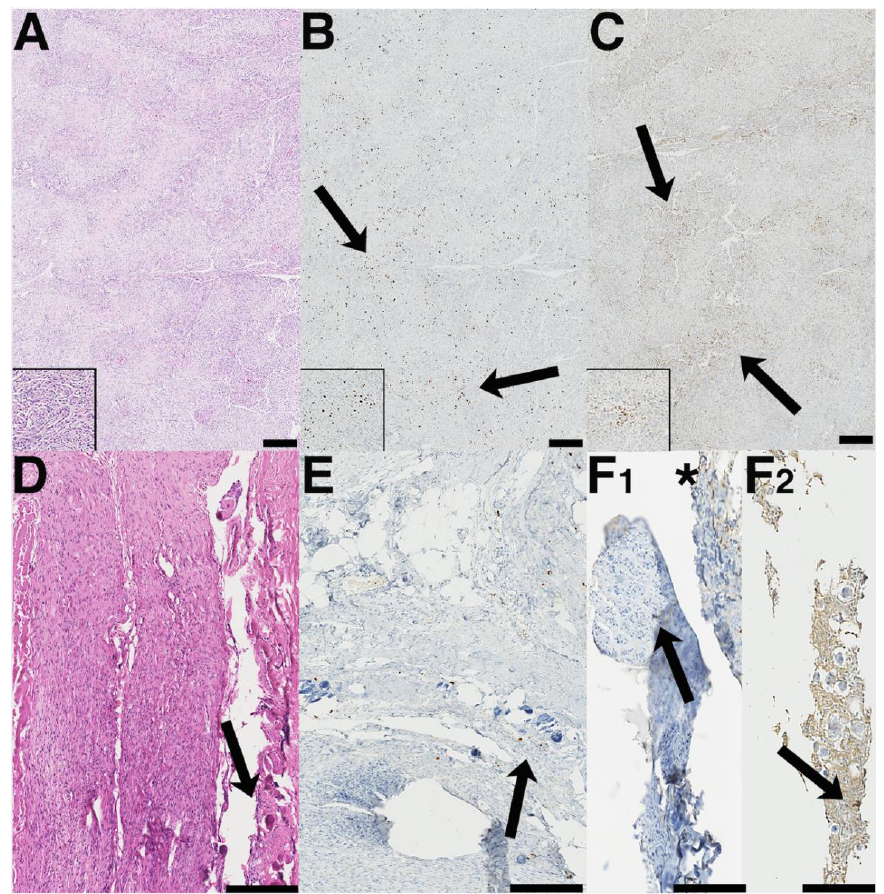
Figure 5. Representative images of two benign (meningothelial) meningiomas with fundamentally different Ki-67-labeling indices and macrophage infiltrates ( A – F ). ( A ) On the hematoxylin and eosin (HE) staining, meningothelial meningioma with high differentiation becomes apparent. Insert: note the whirl-like meningiomal structures that seem to become particular in the higher power magnifi- cation; cellularity is somewhat increased by non-meningioma, i.e., macrophagocytic cells. ( B ) Ki67- positive nuclei are substantially augmented in this tumor, both diffusely and in sometimes clustered distribution (black arrows). Insert demonstrates Ki67-positive nuclear clusters in the tumor. ( C ) The distribution of CD68 − positive macrophage infiltrates overlaps strongly with the areas of increased Ki67-labeling. The pattern of macrophage localization is overall diffuse-like with some interspersed clusters (black arrows). Insert: clustered macrophages in this meningioma. ( D ) Another meningi- oma with lobar growth pattern, syncytium-like appearance, and occasional Psammoma bodies (HE; black arrow). ( E ) Only a few Ki67-positive nuclei are present in this tumor, some of them accentu- ated in the periphery of Psammoma bodies (black arrow). CD68 − positive macrophage infiltrates are